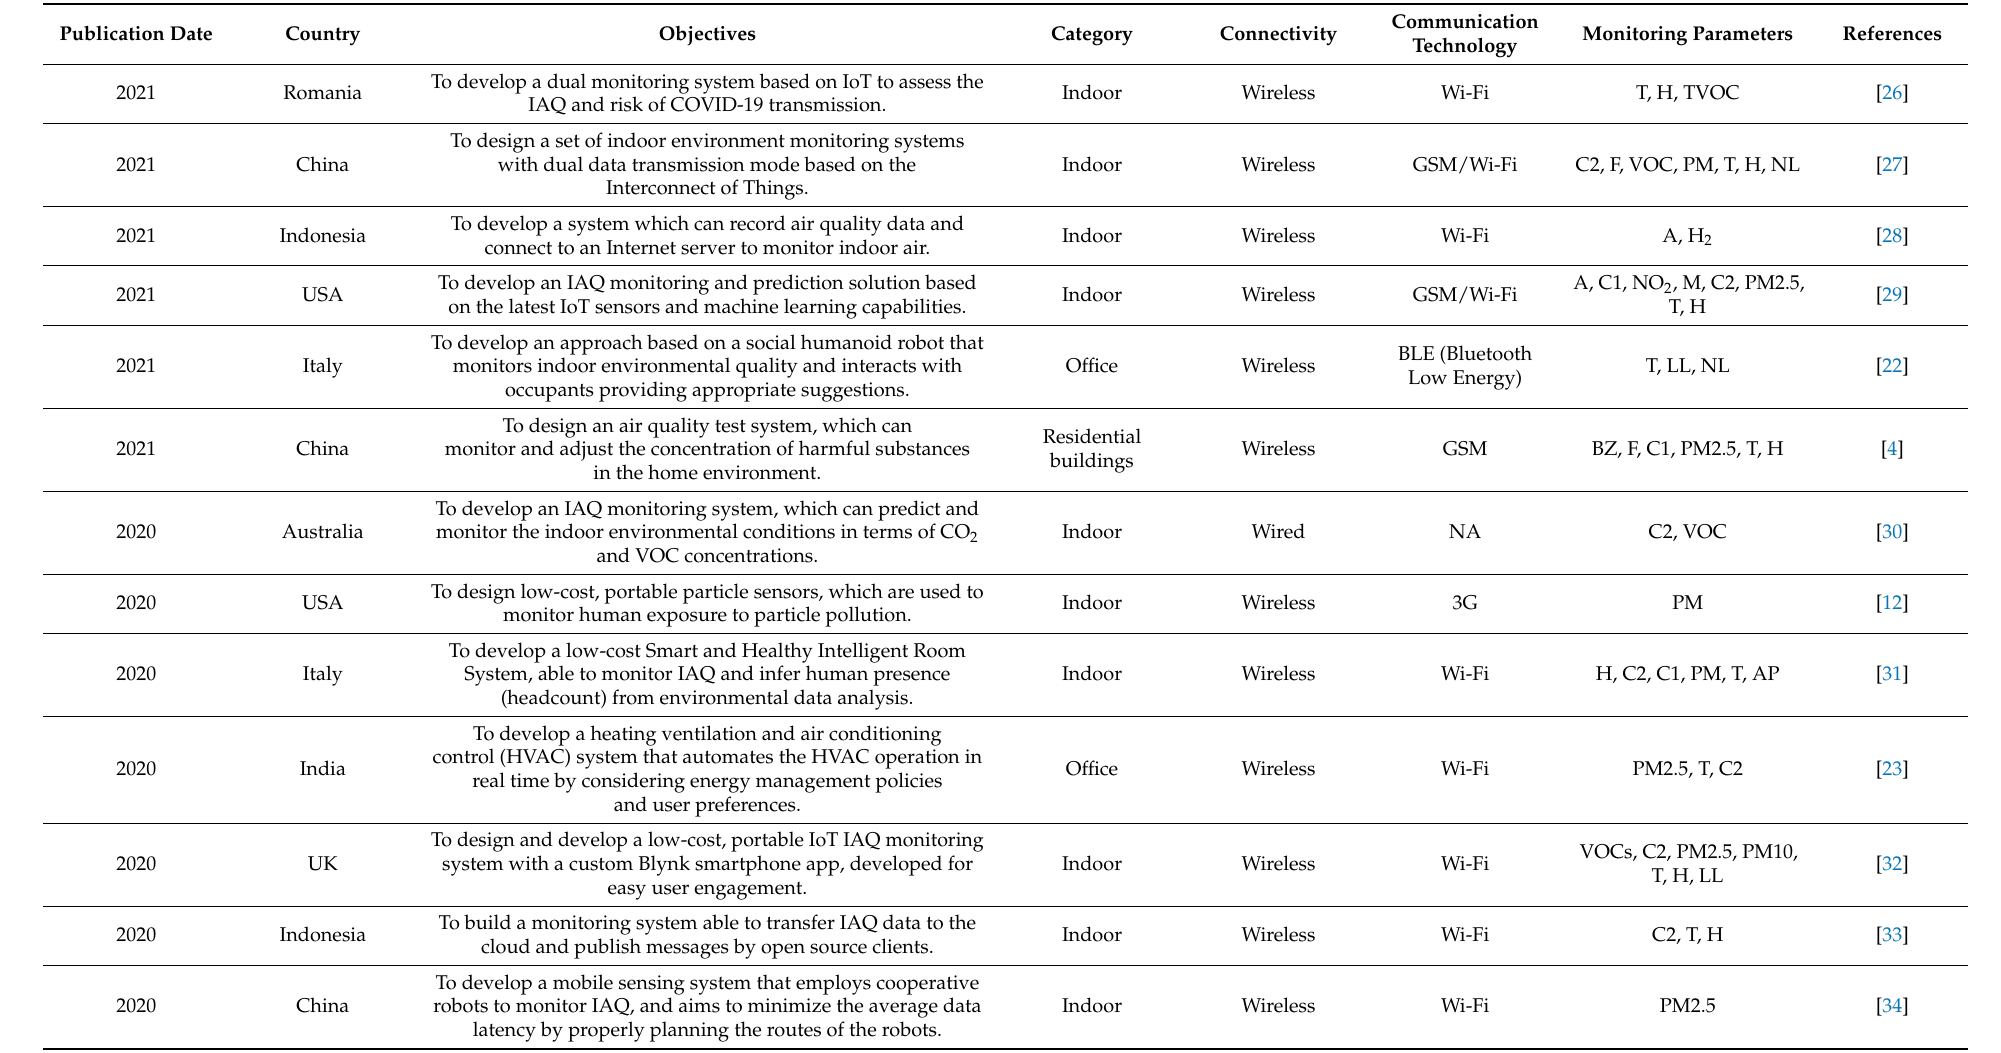
Table 1. The results of device design characteristics are summarized in chronological order of